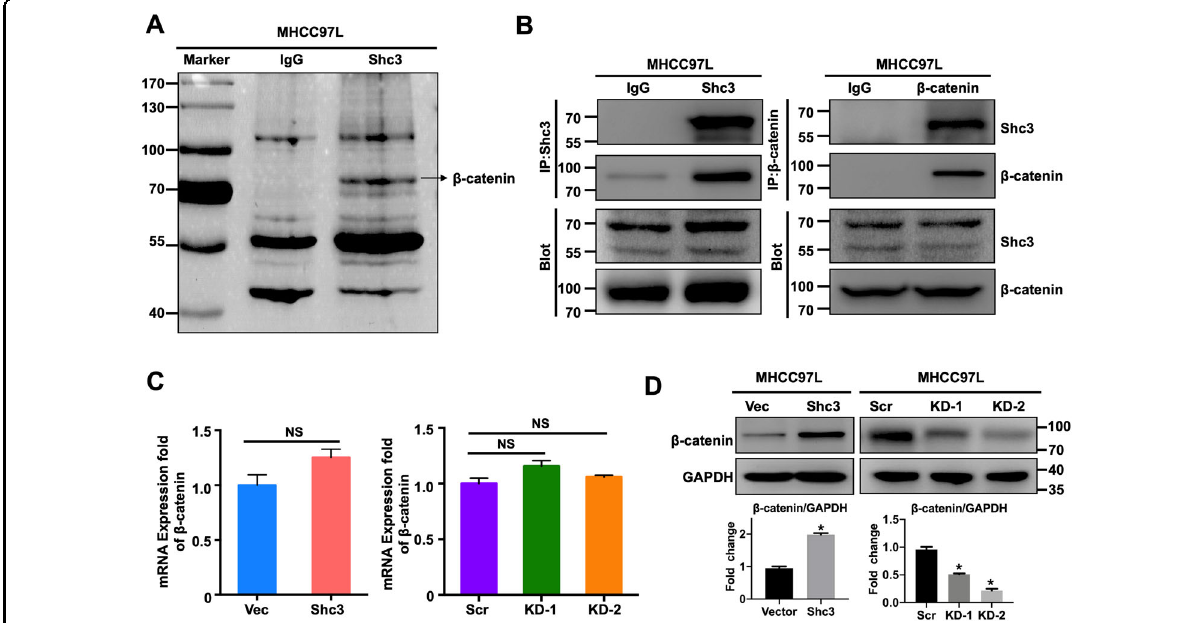
Fig. 4 Shc3 and β -catenin interaction potentiates β -catenin signaling activation. A Image of a silver stained SDS – PAGE gel. IP was performed with MHCC97L cell lysates. Normal IgG was used as a control. B Co-IP of endogenous Shc3 interacts with β -catenin in MHCC97L cells. C , D qRT-PCR and western blot analysis of β -catenin mRNA and protein expression levels in MHCC97L Shc3-overexpressing and Shc3-knockdown cells. Right bottom, the histogram shows the comparison of the relative intensity of β -catenin and GAPDH. Error bars represent the mean ± SD (* P < 0.05 vs. control, by one-way ANOVA or Student ’ s t